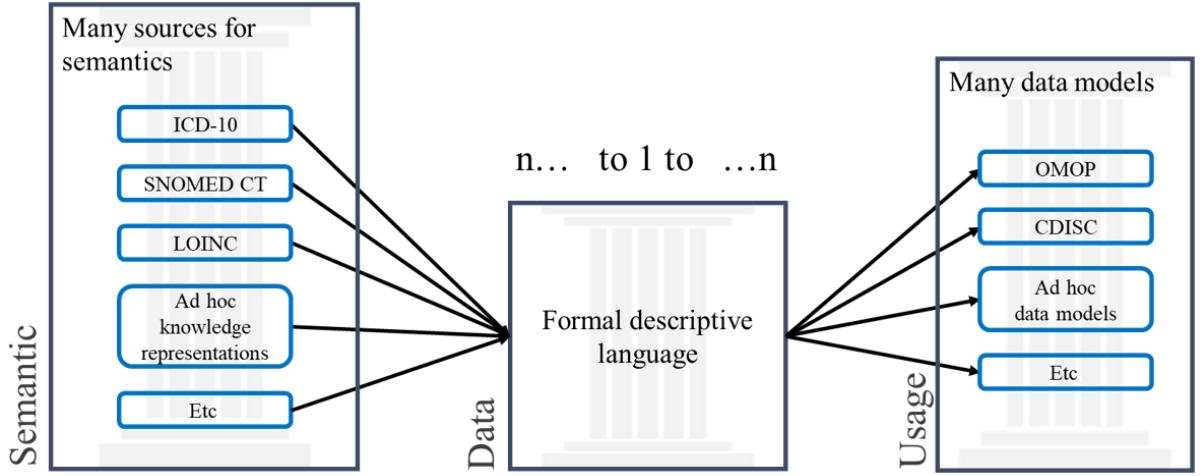
Figure 1. The three pillars of the proposed data interoperability strategy. CDISC: Clinical Data Interchange Standards Consortium; Etc: et cetera; ICD-10: International Classification of Diseases; LOINC: Logical Observation Identifiers Names and Codes; OMOP: Observational Medical Outcomes Partnership; SNOMED CT: Systematized Nomenclature of Medicine Clinical